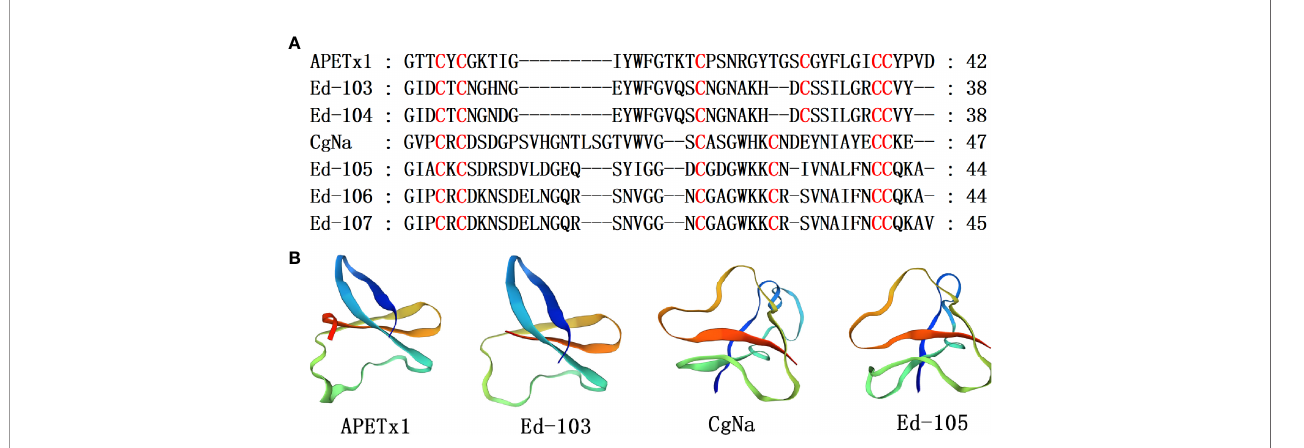
FIGURE 7 | Representative sea anemone mature peptide sequences with b -defensin-like peptides. (A) Alignment of sea anemone mature peptides with b -defensin- like peptides. Cysteines are highlighted in red; (B) Homology modeling prediction of the representative sea anemone mature peptide Ed-103 and Ed-105 with APETx1 ( k -actitoxin-Ael2a; PDB7BWI) and CgNa ( △ -actitoxin-Cgg1a; PDB